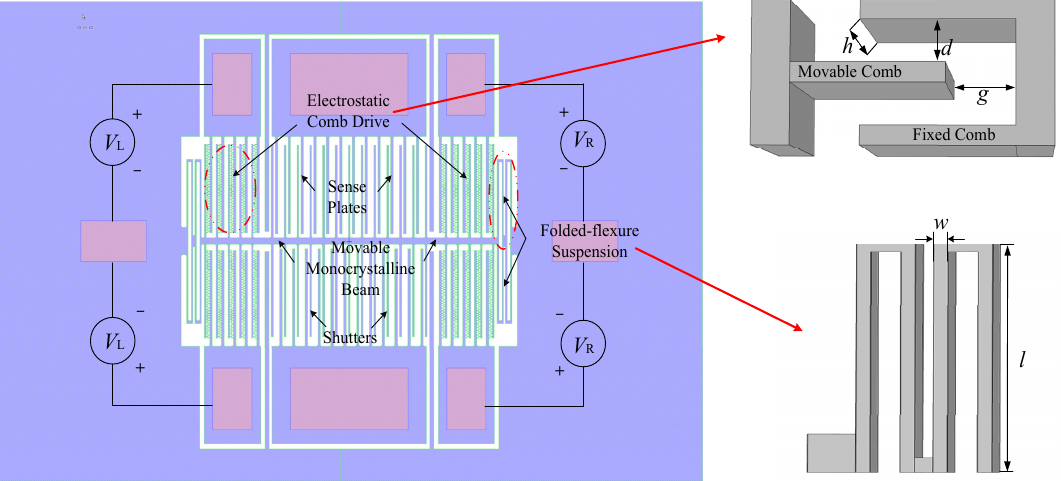
Figure 1. Schematic diagram of the microelectrostatic resonance electric field sensor. The purple structure is the physical structure fabricated from the top silicon film. The pink structures are sputtered metal electrodes. The dimensional parameters shown in the figure are listed in Table 1.